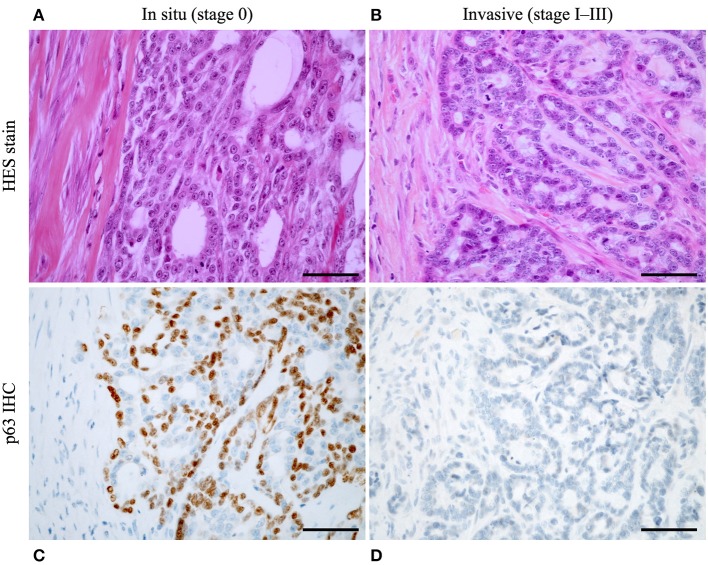
Discrimination between stage 0 (in situ) feline mammary carcinomas and stage I–III (invasive) FMCs using p63 immunohistochemistry. (A) Mammary carcinoma in situ, Hematoxylin-Eosin-Saffron stain. Example of a tubular carcinoma. (B) Invasive mammary carcinoma, HES stain. Example of a tubular carcinoma. (C) Same case as (A), presence of a continuous layer of hypertrophic myoepithelial cells surrounding the neoplastic cells and showing strong nuclear p63 immunoreactivity. (D) Same case as (B), absence of p63+ myoepithelial cells surrounding the neoplastic cells. HES stain (A,B) and P63 immunohistochemistry (C,D), original magnification 400x, scale bar = 50 micrometers.